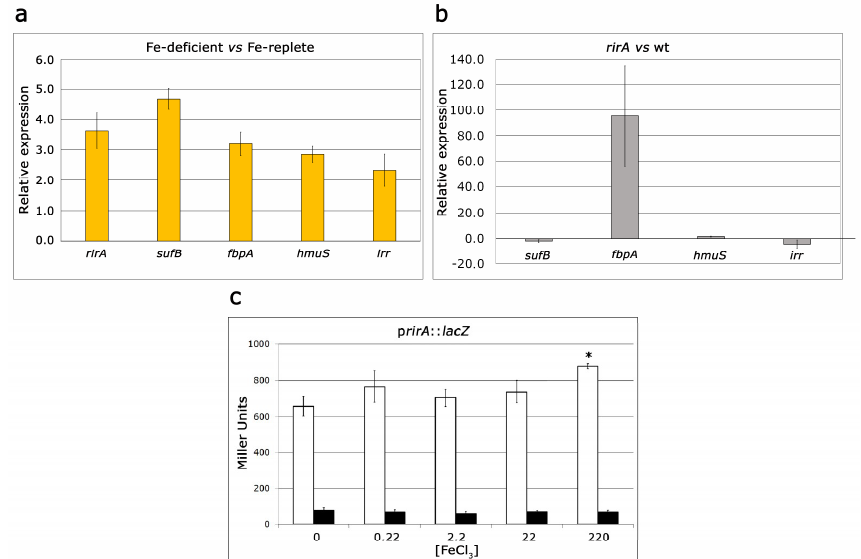
Figure 3. Gene expression analyses of iron-related genes in S. fredii . ( a ) Relative expression of rirA , sufB , fbpA , hmuS and irr genes in the wild-type strain SVQ269 of S. fredii as determined by Reverse Transcription-quantitative Polymerase Chain Reaction (RT-qPCR). The relative expression was calculated as the fold change between growth in iron-deficient (0.22 µM FeCl 3 ) and iron-replete (22 µM FeCl 3 ) media; ( b ) relative expression of iron-related genes in rirA mutant versus wild-type strain after growth in iron-sufficient (22 µM FeCl3) medium as determined by RT-qPCR; ( c ) transcriptional activity of rirA in the SVQ780 mutant (white bars) and complemented strain (SVQ780C) (black bars) after growth in media with different iron concentration as determined by β-galactosidase activity. Results are averages from at least two independent biological experiments with two technical replicates. Error bars indicate standard error. The asterisk indicates significant difference with respect to data obtained in cells grown in un-supplemented media according to ANOVA test ( p < 0.05).